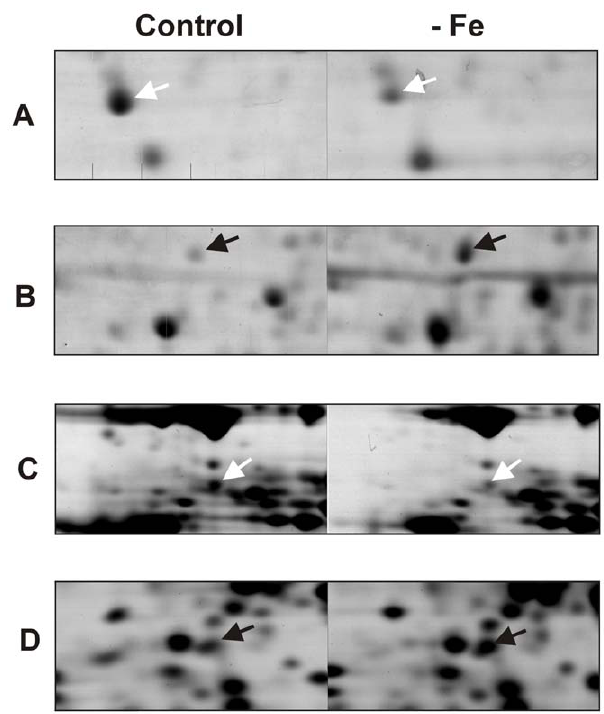
Figure 5. Magnified regions of the protein spots exhibiting protein abundance changes in the 2D gels shown in Figure 4. Protein spots correspond to the following proteins identified by mass spectrometry; Y20 protein (A), ATP synthase subunit beta (B), Tubulin alpha-1 chain (C), Conserved hypothetical protein (D). Black and white arrows indicate up-regulated and down-regulated proteins respectively.